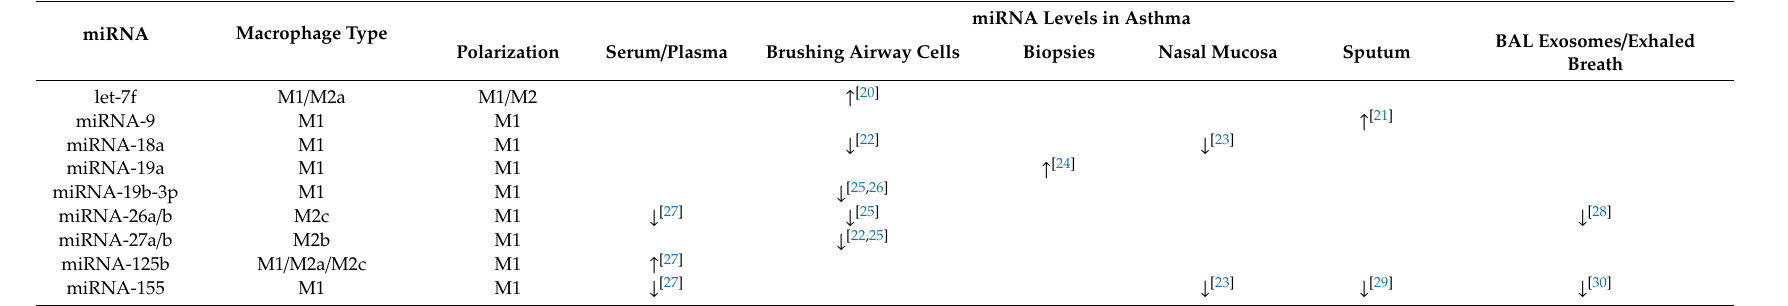
Table 1. Pro-inflammatory miRNA levels in